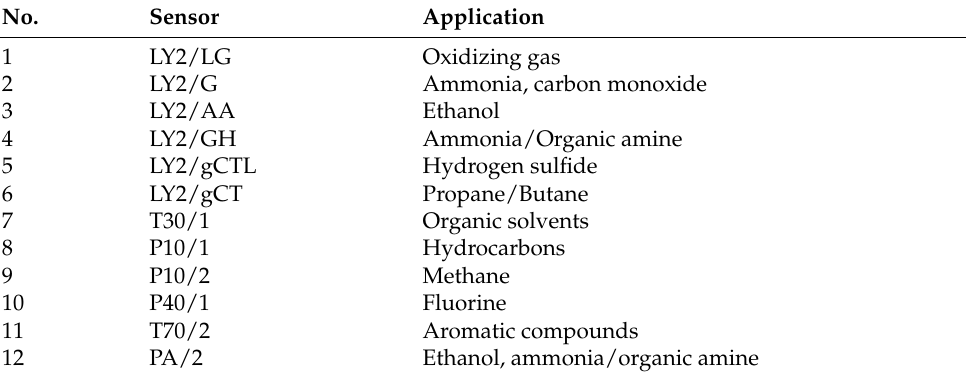
Table 1. Main application of 12 metal oxide semiconductor sensors in FOX3000, Alpha MOS e-nose